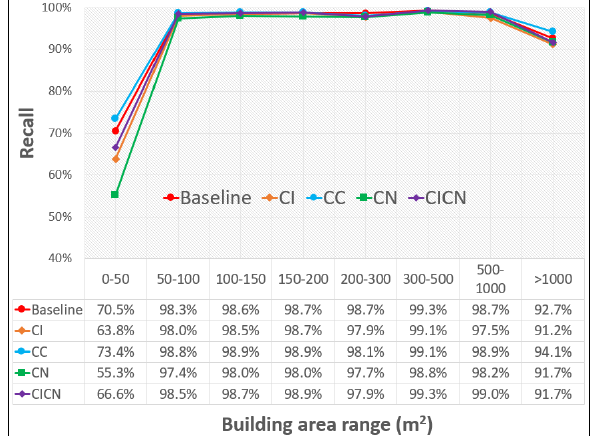
Figure 8 . Effect of building area on recall.